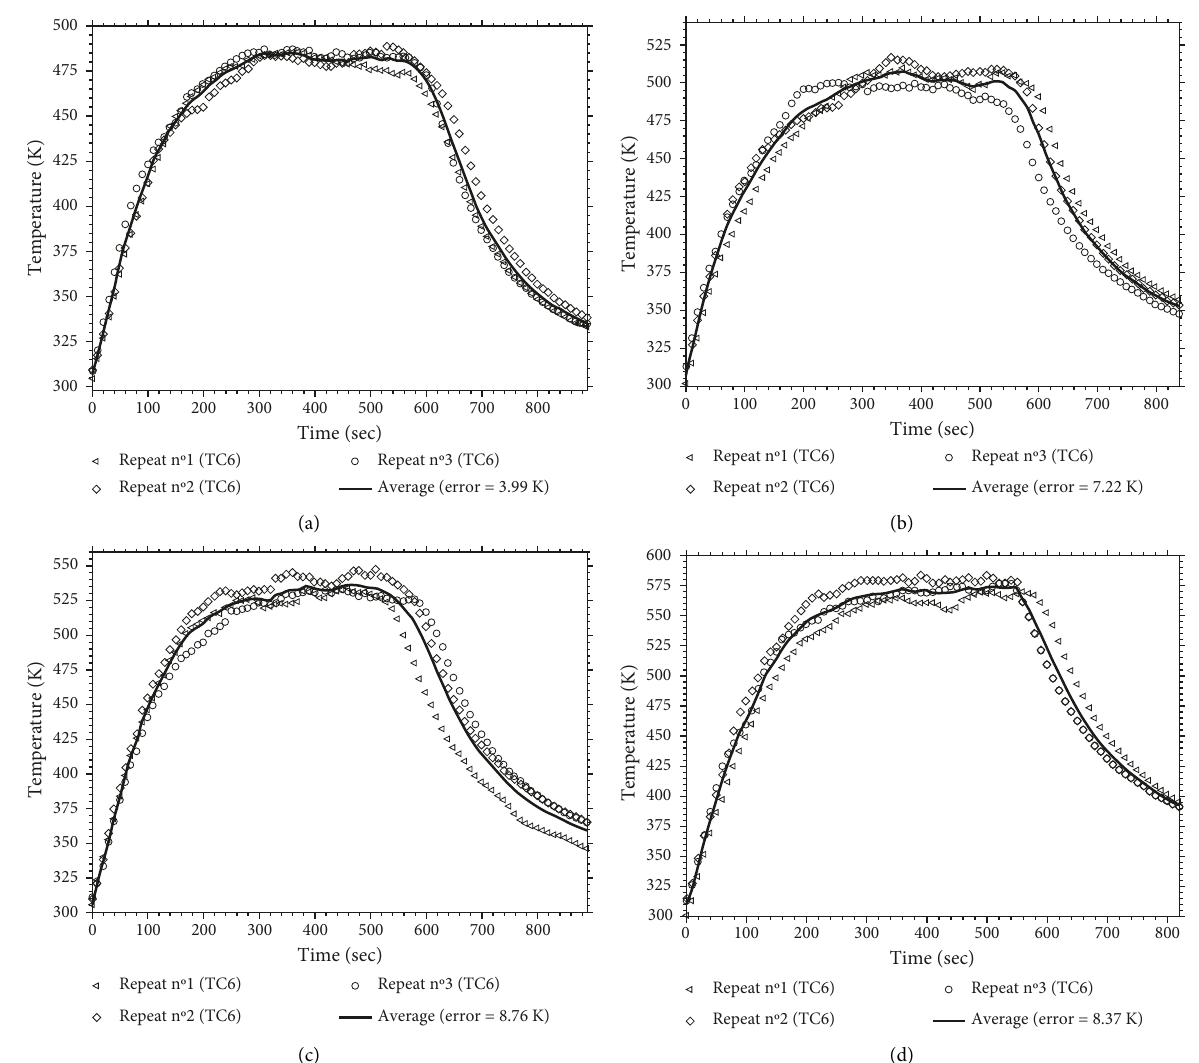
Figure 5: Illustration of the repeatability of the experimented fire scenes. (a) Scene 1 (